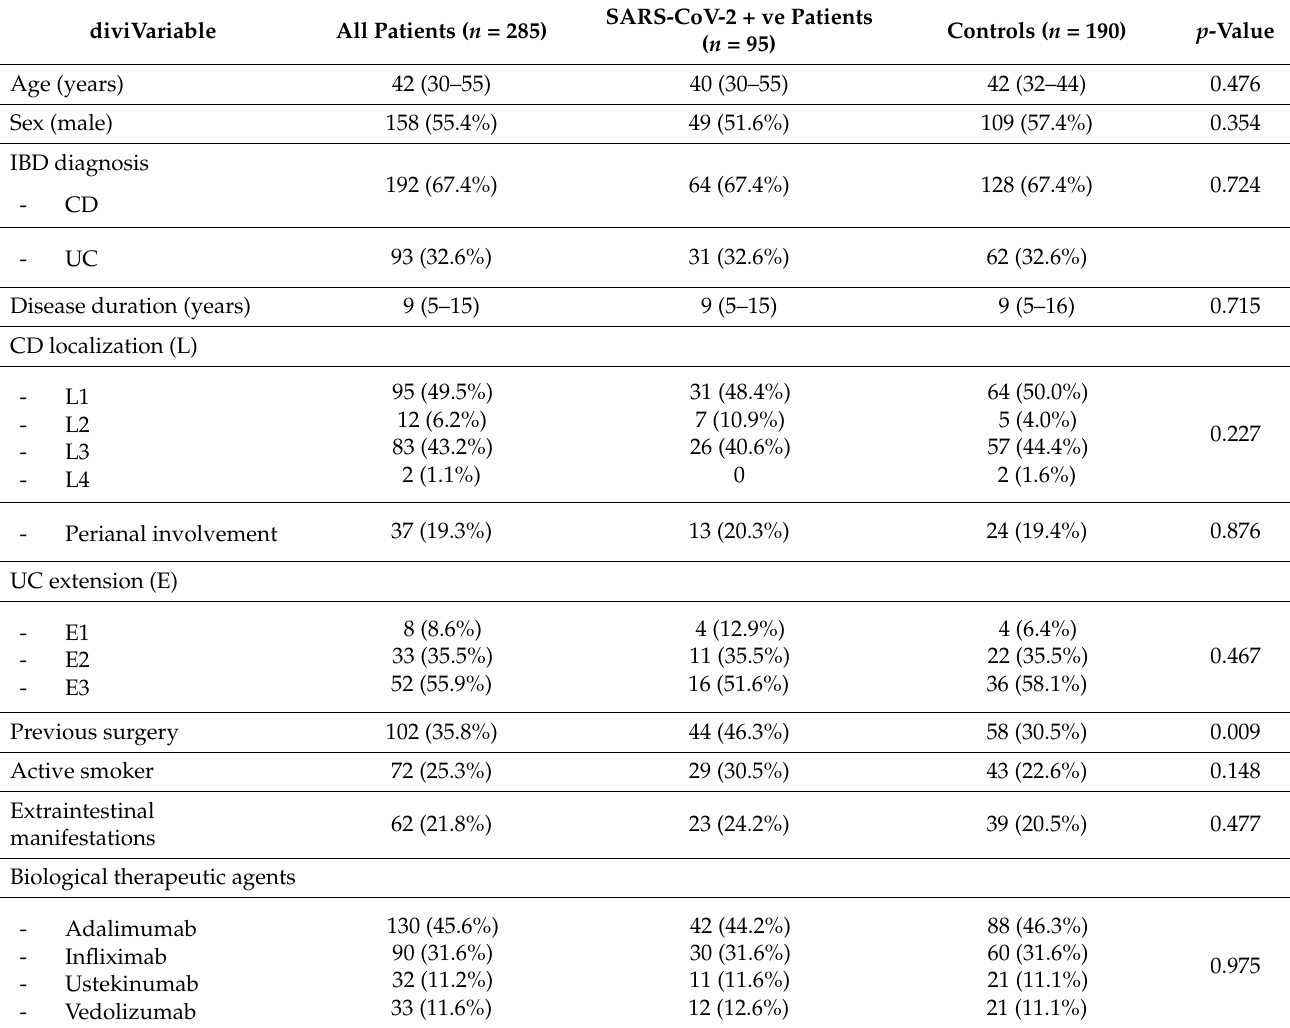
Table 1. Clinical characteristics of the study